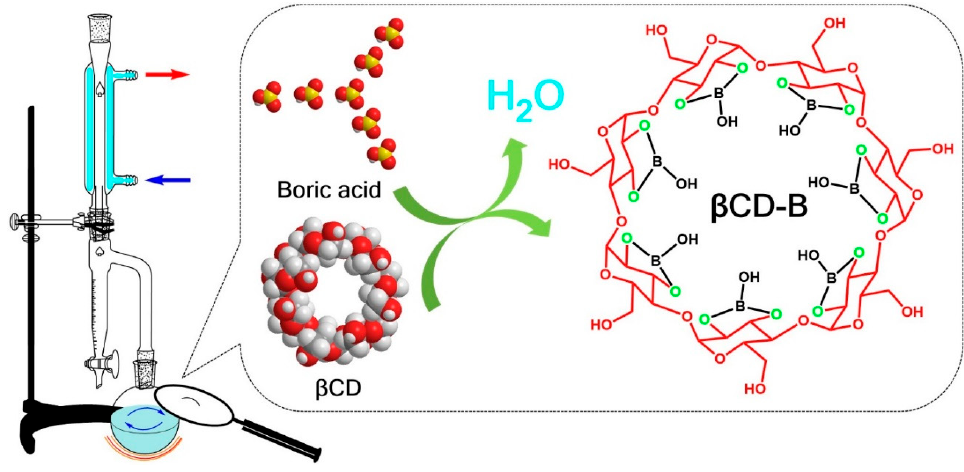
Figure 1. Schematic process for preparing β –cyclodextrin-boric acid ( β CD–B) complex.